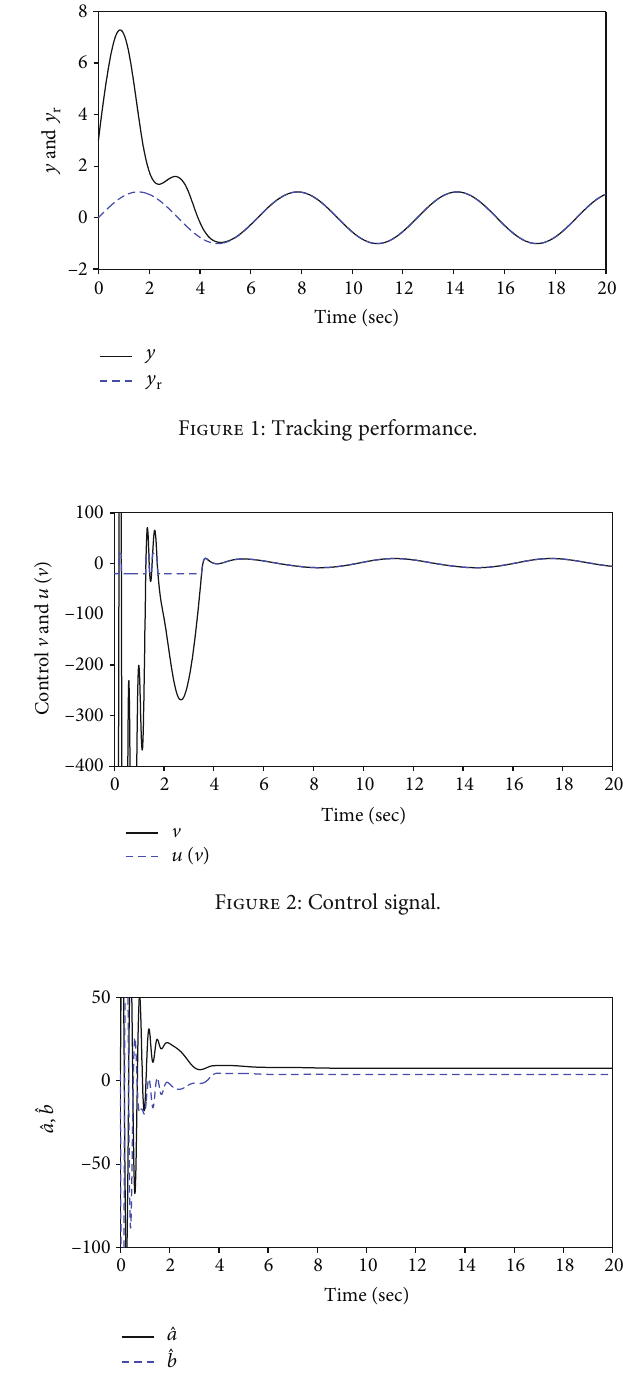
Figure 3: Time response of the parameter